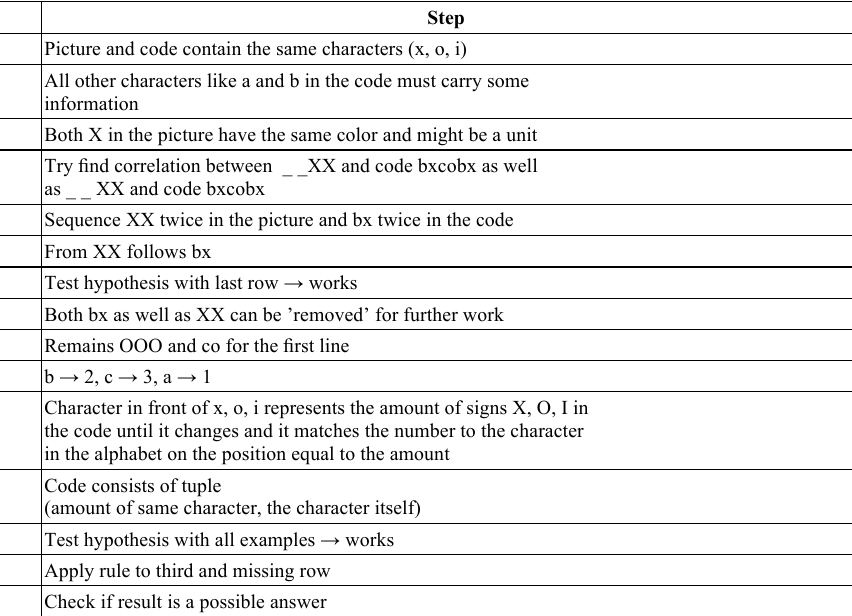
Table 4. Steps of a test person’s think aloud process that lead to the correct